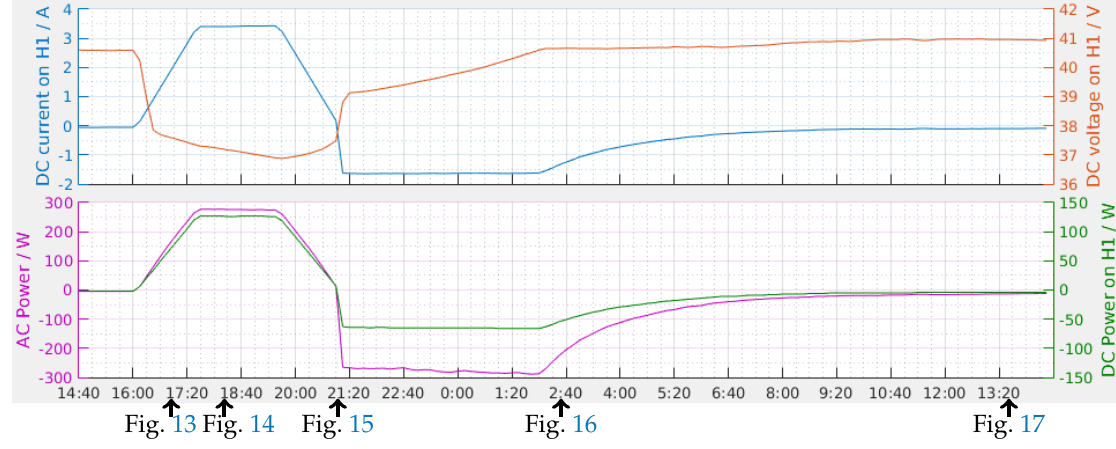
Fig. 13 Fig. 14 Fig. 15 Fig. 16 Fig. 17 Figure 12. 24 h log of key signals, sampled at each 10min.